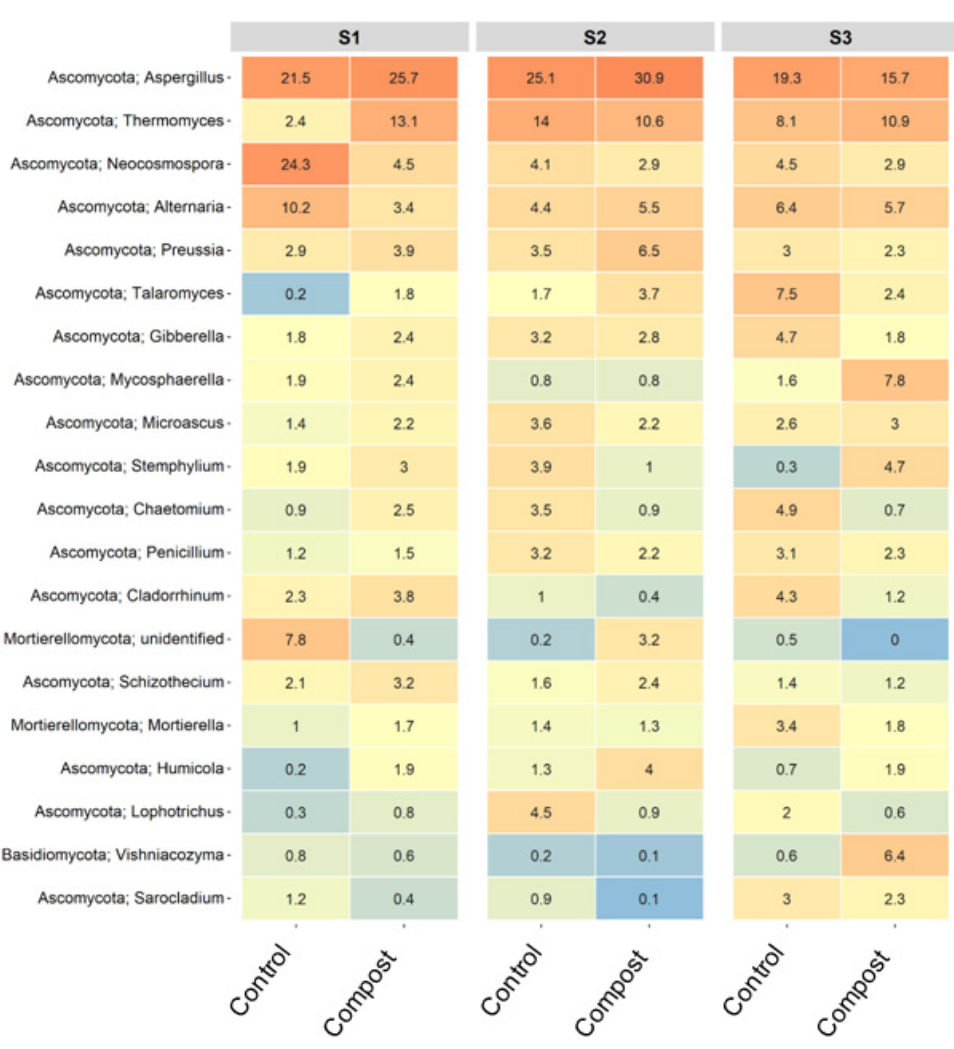
Figure 5. The heatmap of the correlation between fungal orders and treatments at tillering (S1), booting (S2) and ripening stage (S3).